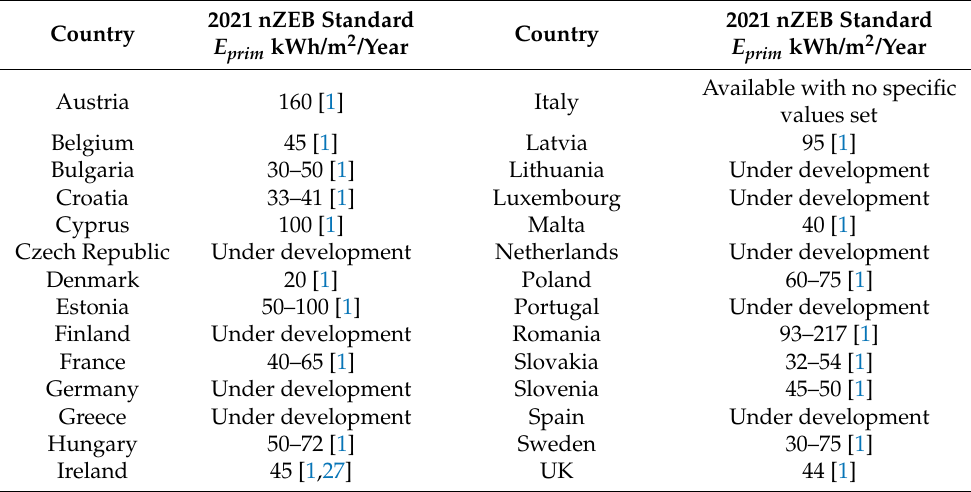
Table 1. nZEB standards across the UK and